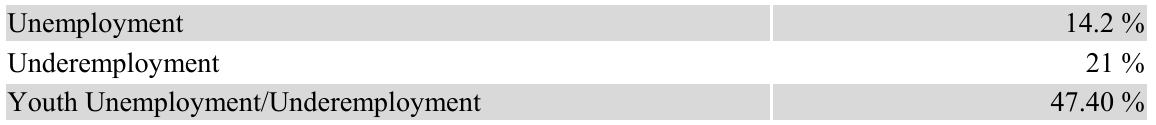
Unemployment/Underemployment Indicators in Nigeria for Q4 2016 Unemployment 14.2 % Underemployment 21 % Youth Unemployment/Underemployment 47.40 % Source: National Bureau of Statistics